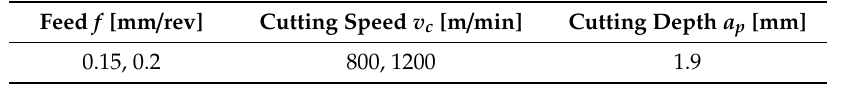
Table 3. Plan of the non-free orthogonal grooving test employed for an evaluation of tool wear.